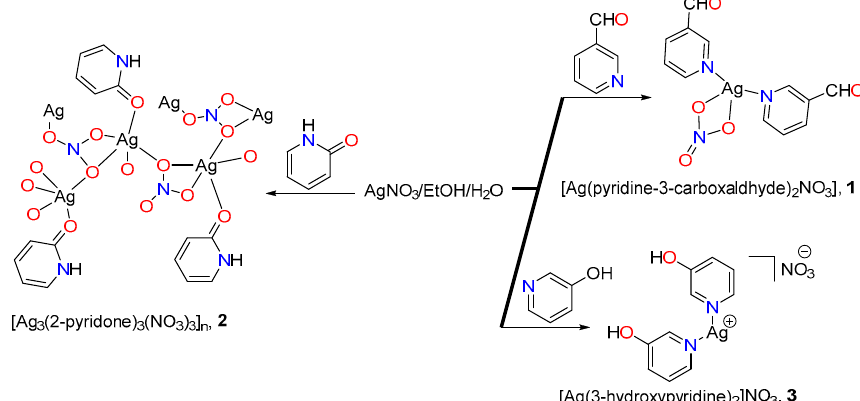
Figure 1. The representative schematic presentation for the synthesis of the target complexes 1 – 3 1 – 3 .